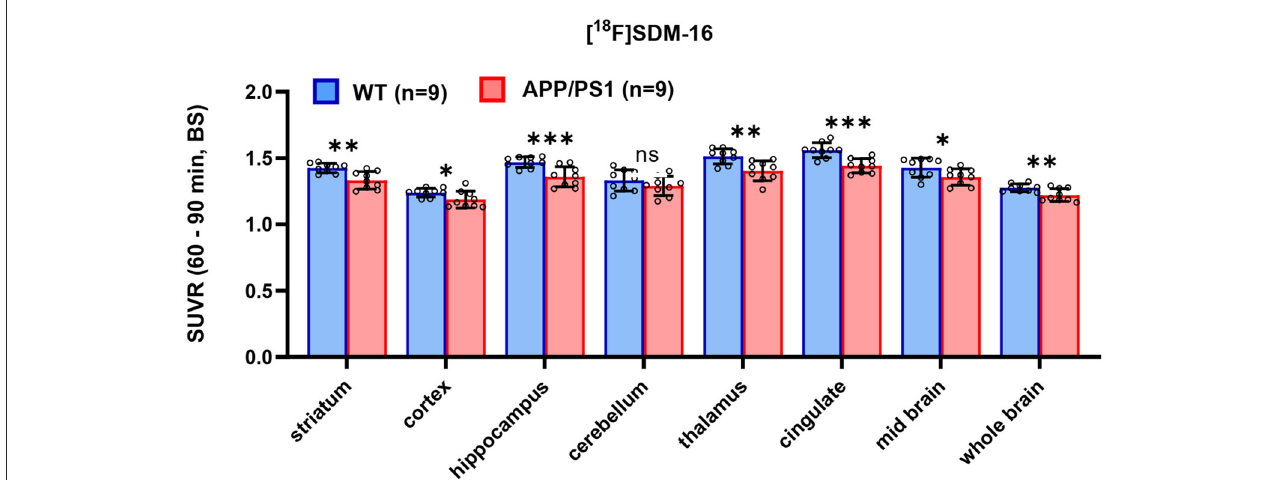
FIGURE3 Comparison of SUVR in selected brain regions for WT and APP/PS1 mice ( n = 9 for each group, *** p < 0.001; ** p < 0.01; 0.01 < * p ≤ 0.05; ns, statistically non-significant).